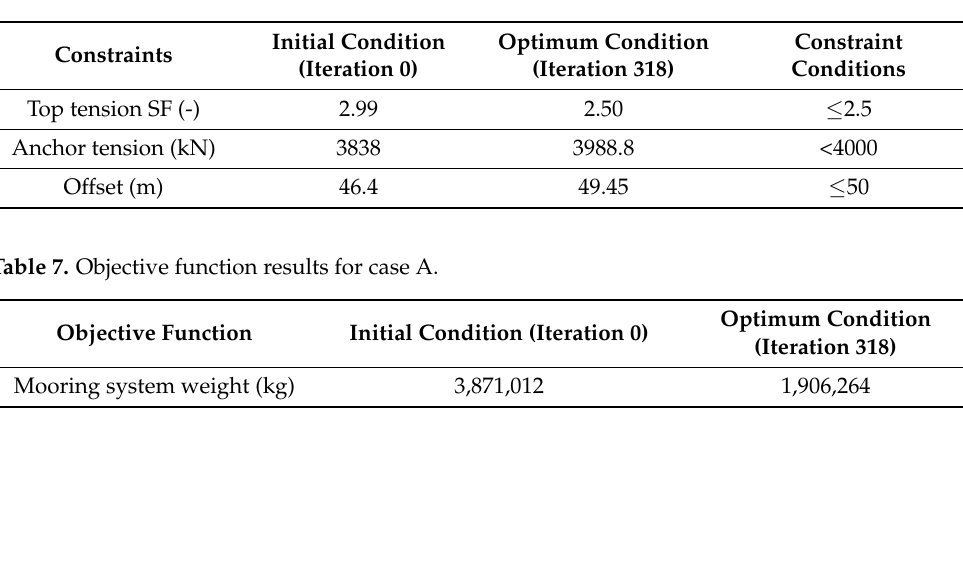
Table 6. The constraint results for case A.